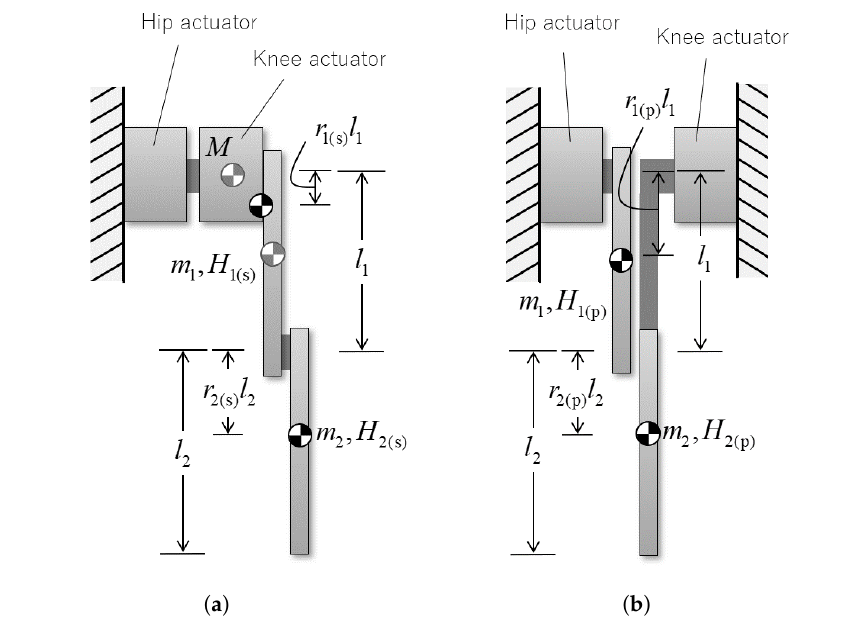
Figure 7. Actuator configuration: ( a ) serial; ( b )